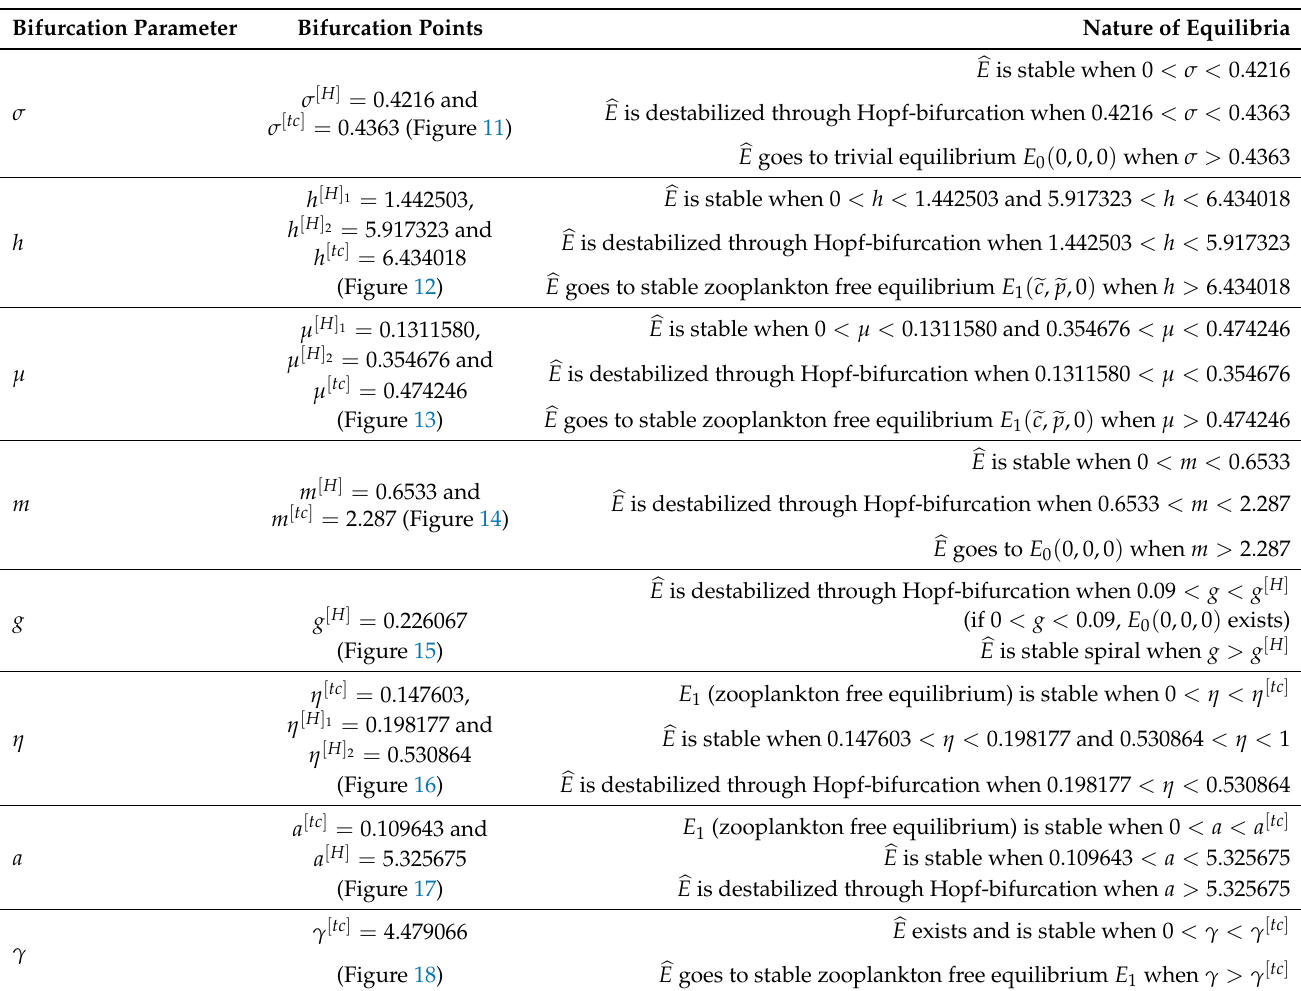
Table 2. Nature of the steady states when the parameters are chosen from Figure 6. Here, ‘H’ stands for the Hopf-bifurcation point, and ‘tc’ stands for the transcritical bifurcation point. Bifurcation Points Nature of